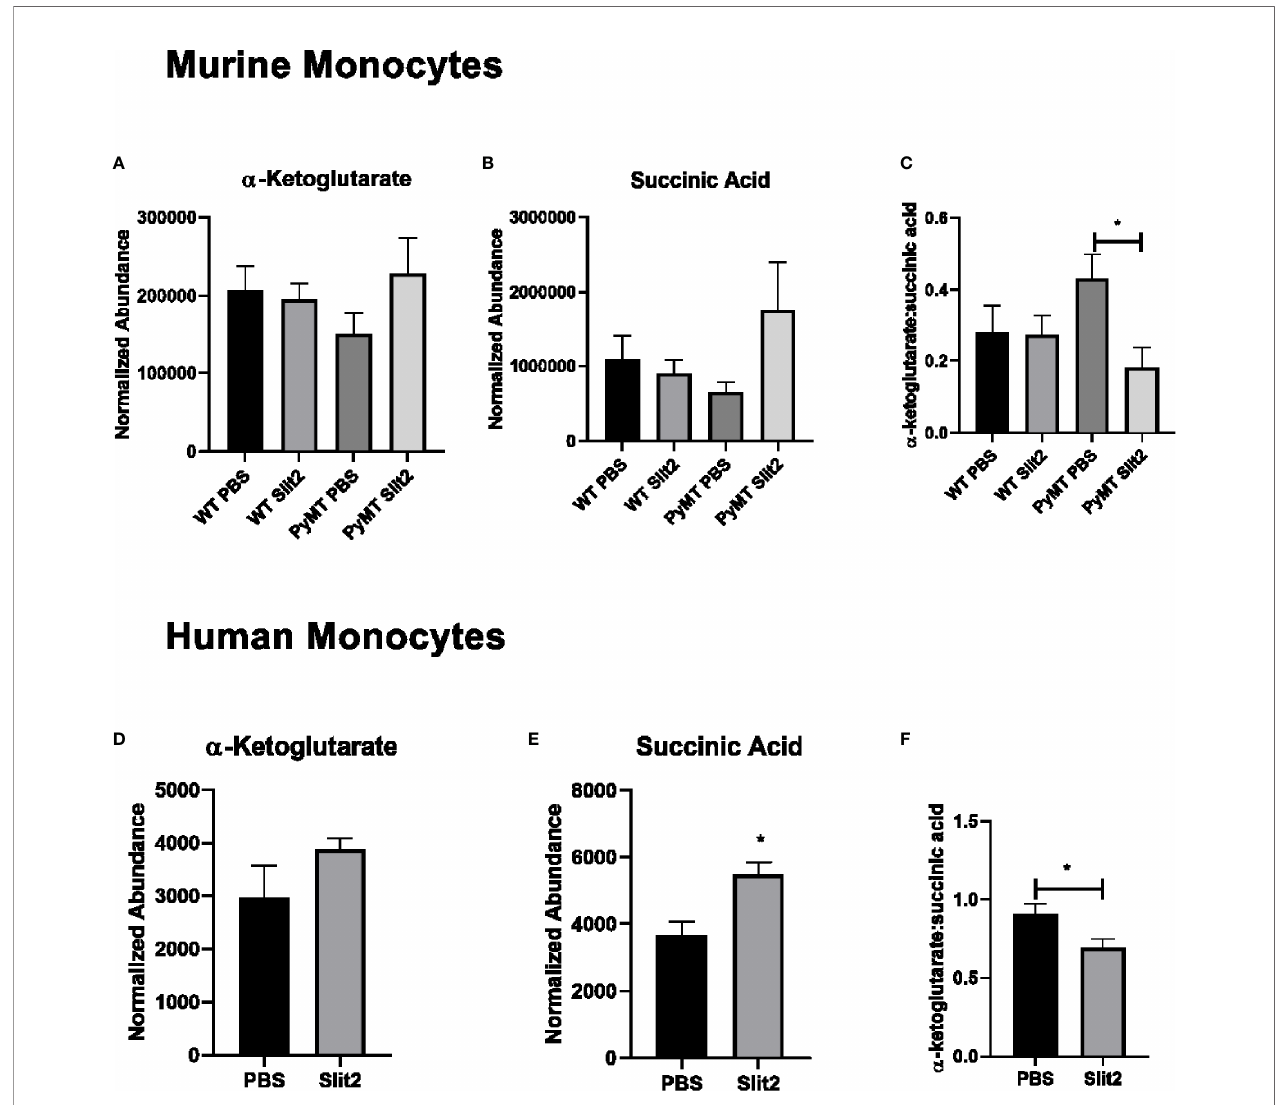
FIGURE 4 | (A) Relative abundance of a -ketoglutarate in PBS- and Slit2-treated WT and PyMT mouse BMDMs. (B) Relative abundance of succinic acid in PBS- and Slit2-treated WT and PyMT mouse BMDMs. (C) Ratio of a -ketoglutarate:succinic acid in PBS- and Slit2-treated WT and PyMT mouse BMDMs. (D) Relative abundance of a -ketoglutarate in PBS- and Slit2-treated human BMDMs. (E) Relative abundance of succinic acid in PBS- and Slit2-treated human BMDMs. (F) Ratio of a -ketoglutarate: succinic acid in PBS- and Slit2-treated human BMDMs. Images represent n = 4 – 6/group. *p < 0.05, assessed by unpaired